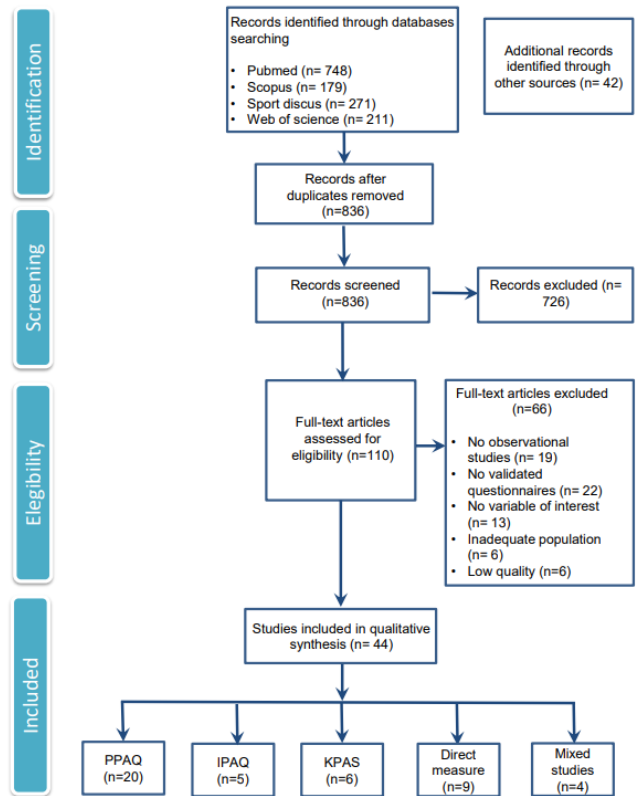
Figure 1. Flow chart of the results in each of the study development phases.